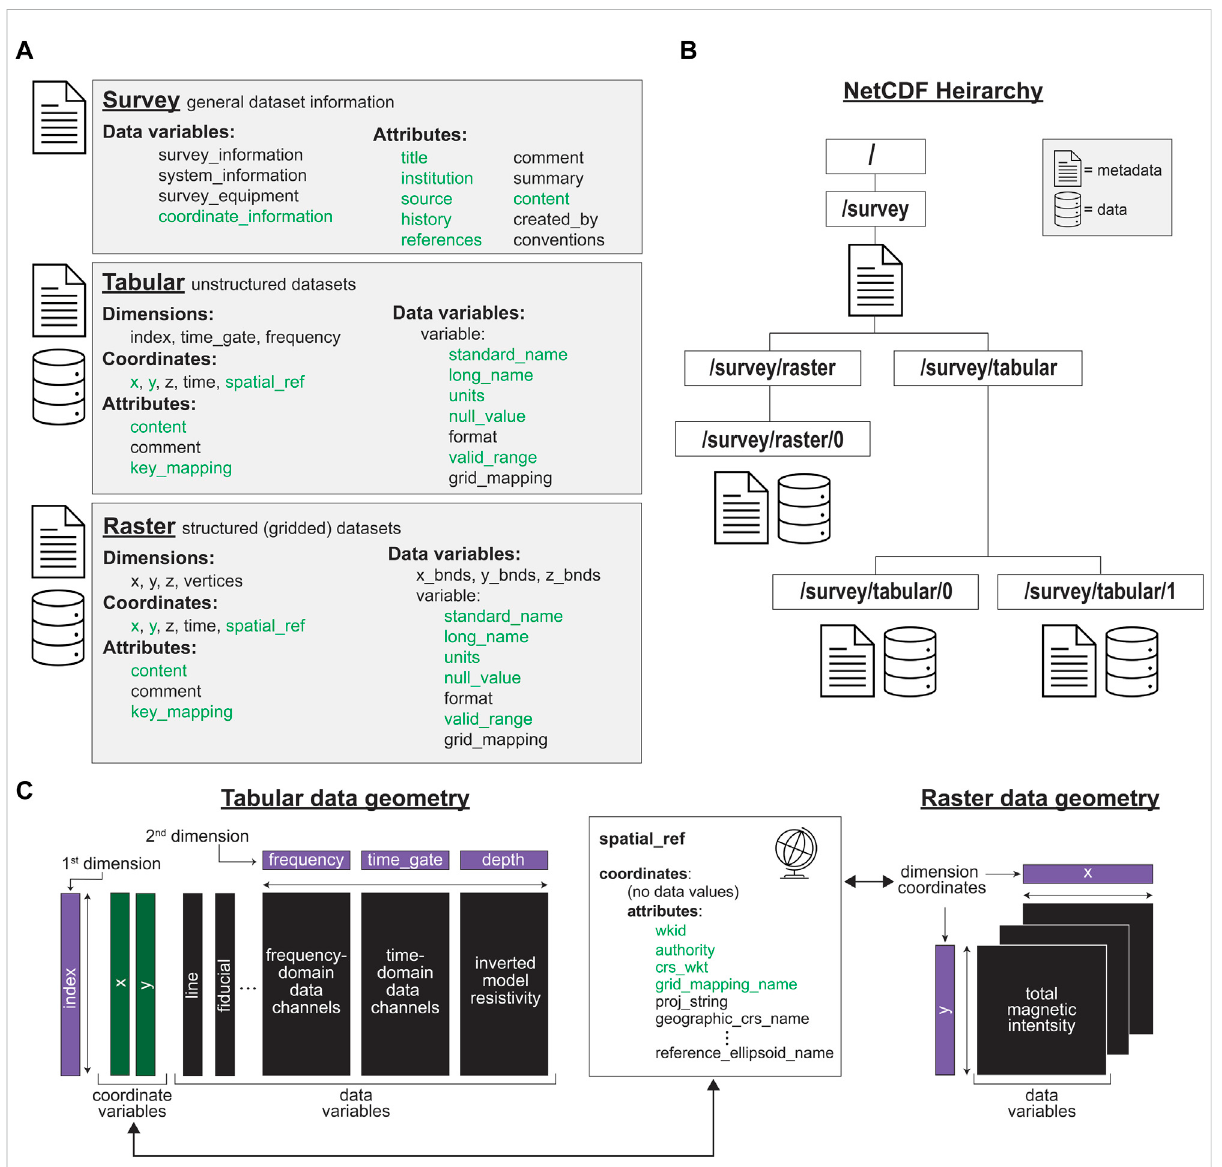
FIGURE 2 GS data convention. (A) Datasets are structured into three fundamental group types based on content and data geometry. The Survey group contains general metadata about the dataset. Unstructured datasets, such as from CSV or TXT fi les, form Tabular groups, whereas structured (gridded) datasets are categorized under the Raster group. Metadata is attached to all groups, with various required attributes (green text) that expands on theCF-1.8 convention. (B) Groupsfollow astrict hierarchy in theNetCDF fi le,with asingle Survey group atthe top to which all data groups are attached. Datasets are indexed within their respective group type. (C) Tabular and Raster data groups must contain clearly de fi ned dimensions, such as index or x, y, z, as well as coordinate variables. Raster groups are distinct in that dimensions are also coordinates, whereas Tabular datasets are assigned spatial coordinates that align with the index dimension. Lastly, the coordinate variable “ spatial_ref ” is required for all data groups, which expands on the “ coordinate_information ” variable required in the Survey